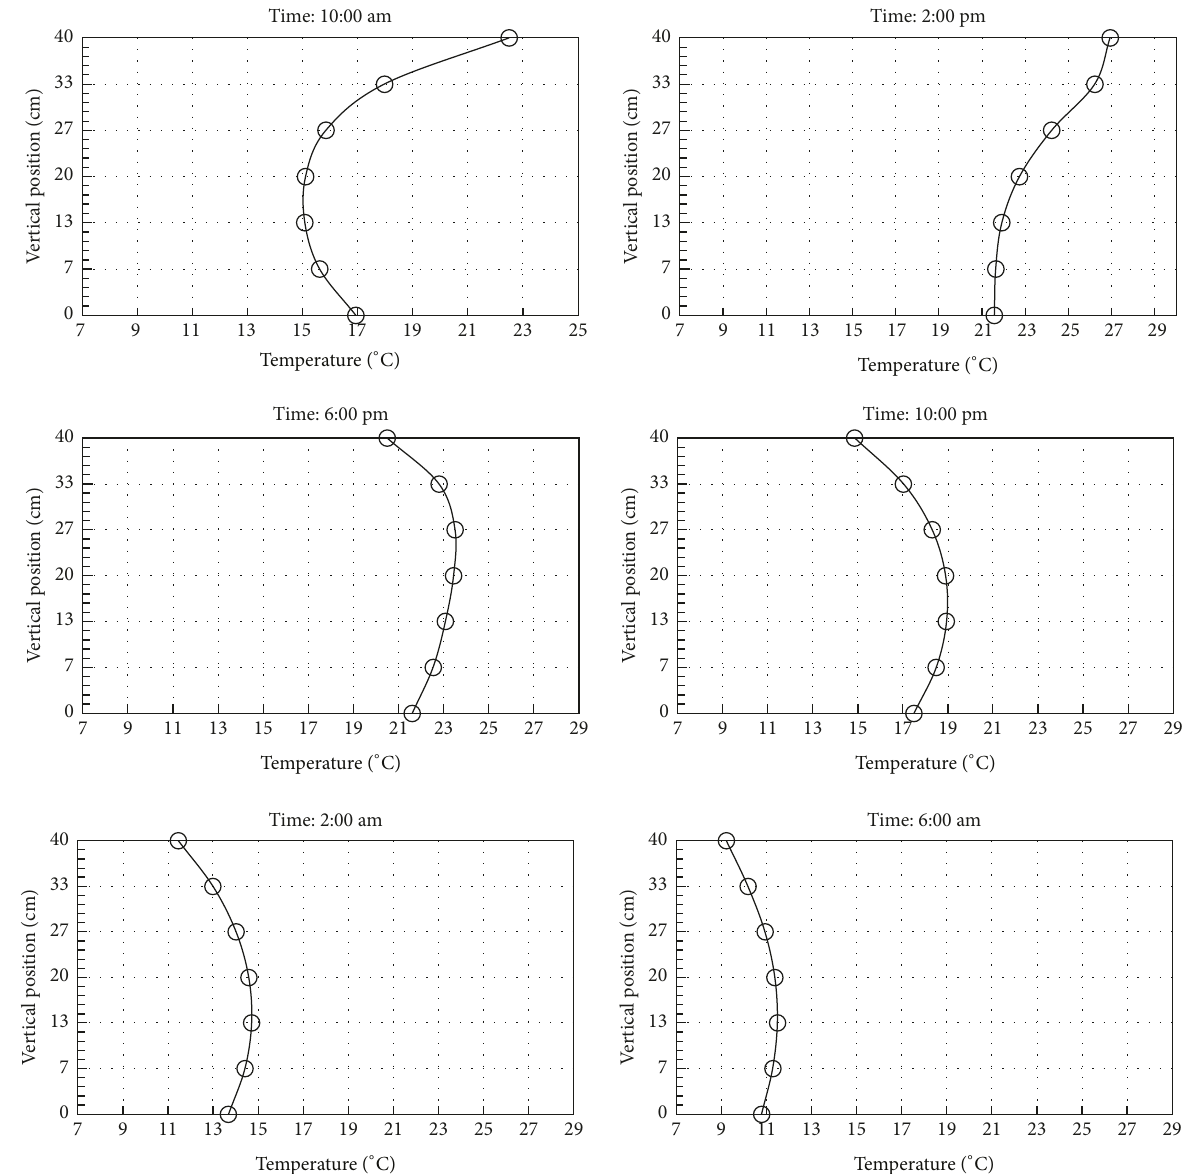
Figure 11: Temperature distribution along the 𝑧 -axis direction at different